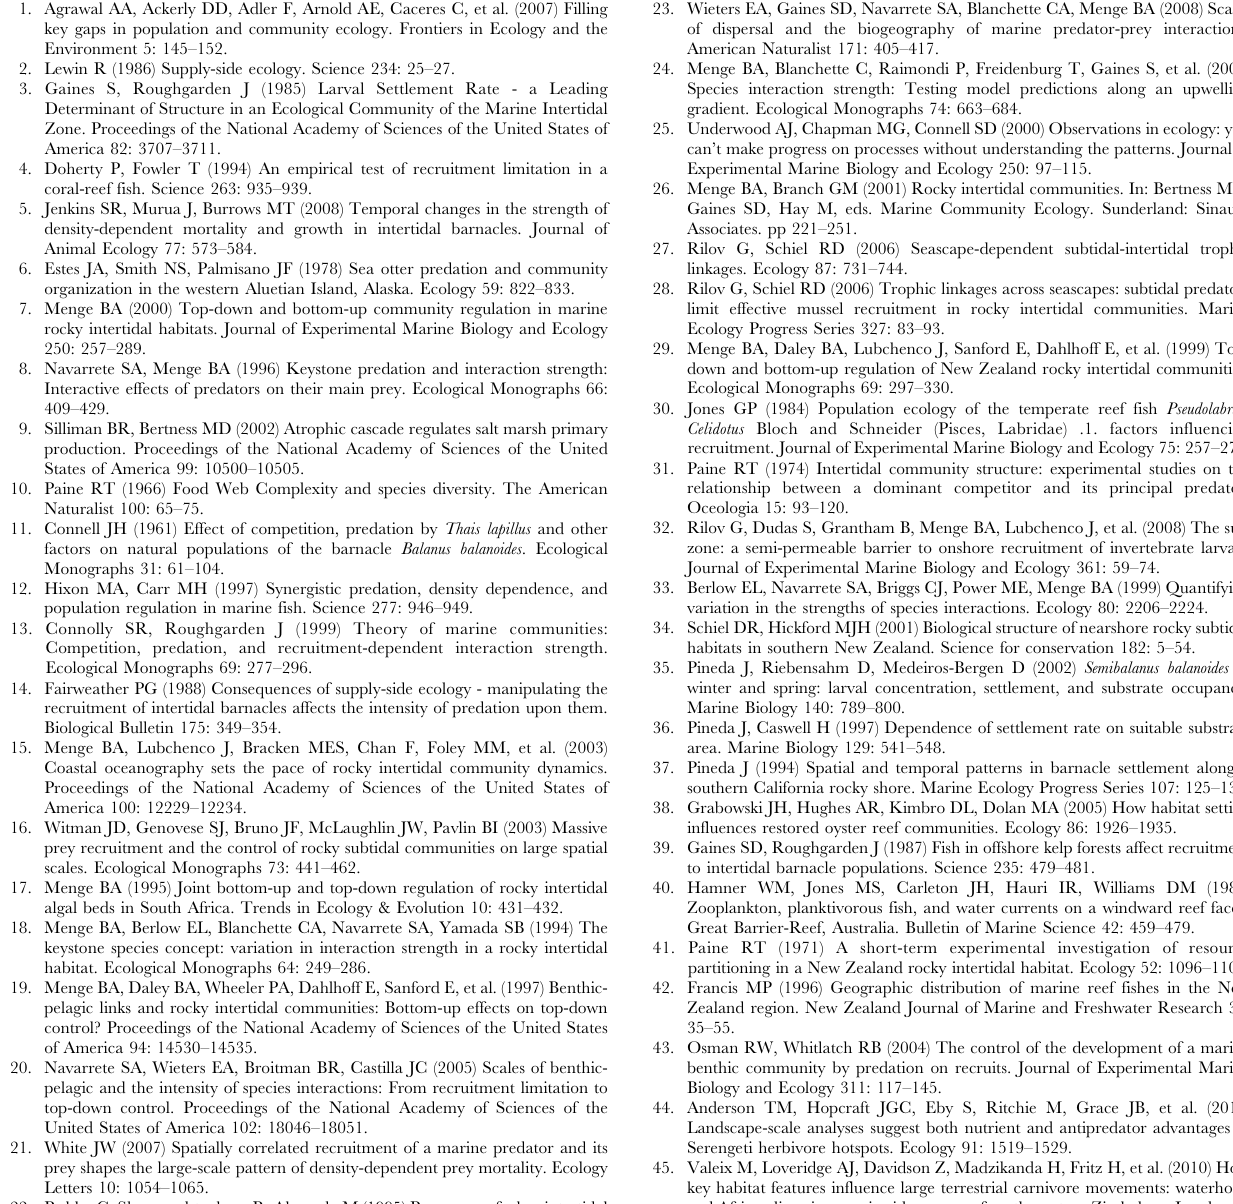
sites. Banded wrasse = Notolabrus fucicola , Spotty = . Notolabrus celidotus .